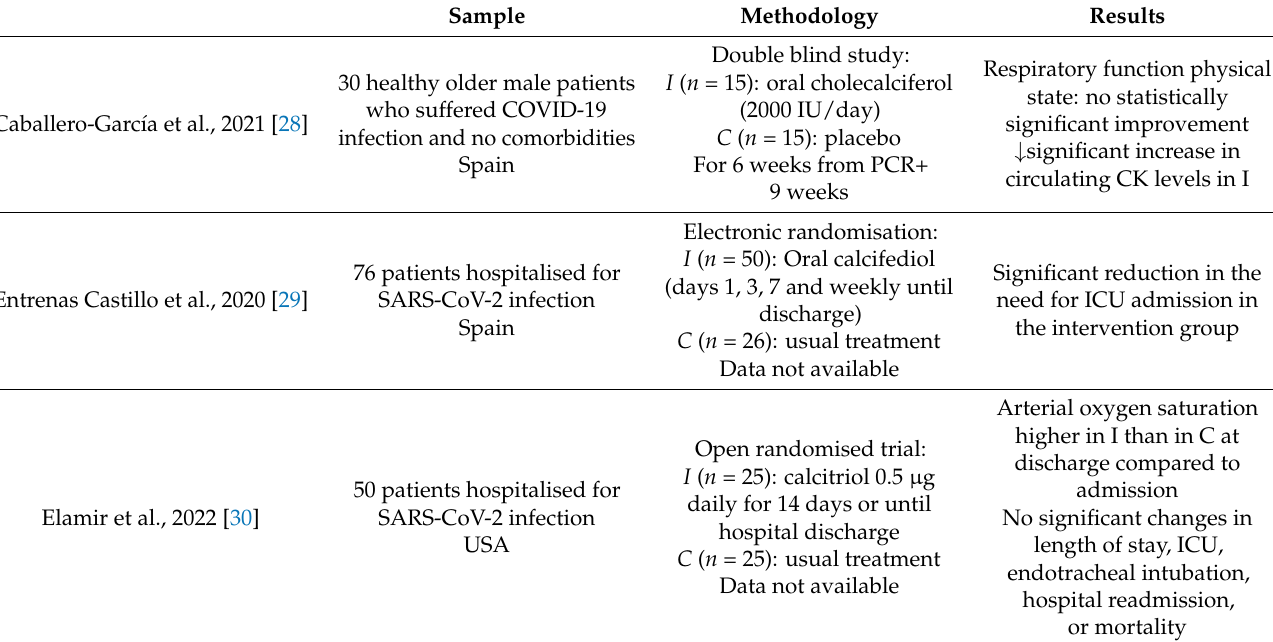
Table 2. Characteristics of the studies